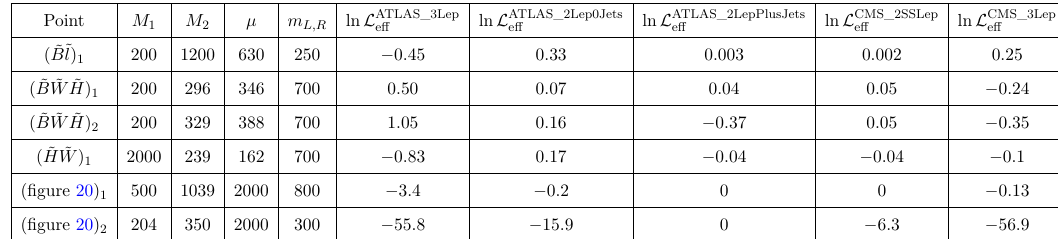
Table 4. Definitions and basic properties of sample parameter points. The first four points represent the ( ˜ B ˜ l ) -, ( ˜ B ˜ W ˜ H ) -, and ( ˜ H ˜ W ) -scenarios and correspond to points in figures 16 and 18 with particularly bad fit to experiment (though not excluded). The last two points represent the excluded region in figure 20. The columns ln L analysis display effective analysis-specific log-likelihood eff differences obtained by GAMBIT / ColliderBit as described in section 6.2 and in ref. [530]. They correspond to the ATLAS analyses of ref. [487] for the 3-lepton, 2-lepton 0-jet and 2-lepton+jets channels, and to the CMS analyses of ref. [520] for the 2-same sign lepton and 3-lepton channels.